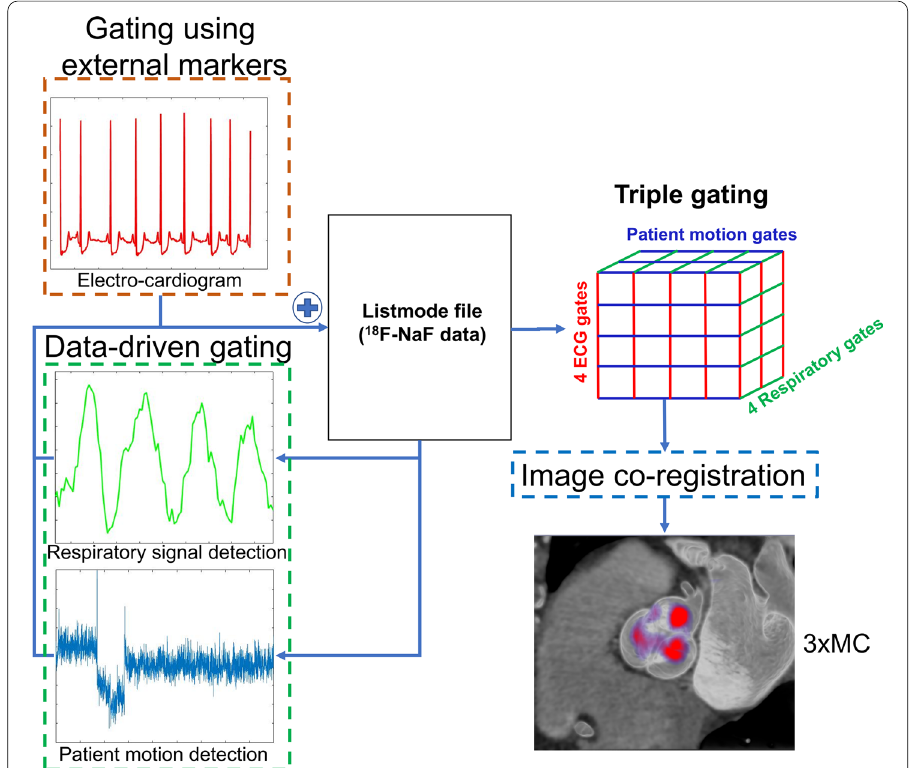
Fig. 1 Overall scheme for simultaneous cardiorespiratory and gross patient motion detection and correction of 18 F-NaF aortic valve PET scans. A fixed number of respiratory and electrocardiogram (ECG) gates (4 each) were used. The number of patient repositioning gates depended on the number of repositioning events the patient had during the acquisition. A 3D mesh of gated reconstructions were obtained, which were registered to generate the 3 MC image set. 3 MC triple × × =